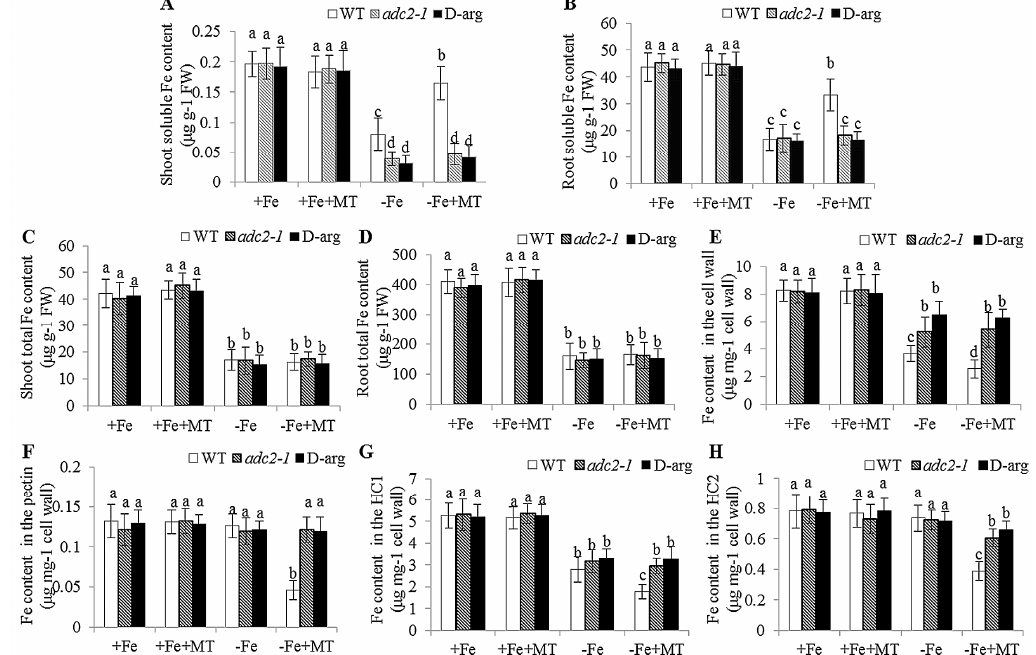
Figure 4. The effect of exogenous melatonin on Fe content in the WT, adc2-1 and D -arg-treated Arabidopsis plants. Seven-day-old seedlings were treated with or without 5 μ M melatonin in the presence or absence of 50 μ M Fe for 8 days. Then these plants were taken to measure the soluble Fe content of shoots ( A ) and roots ( B ), the total Fe content of shoots ( C ) and roots ( D ), and to measure the Fe content in root cell wall components: total cell wall ( E ), pectin ( F ), HC1 ( G ), and HC2 ( H ) fractions. Each bar is the mean ± SE of at least three replicates, and different lowercase letters above the bars indicate significant difference using Tukey’s test at p < 0.05.